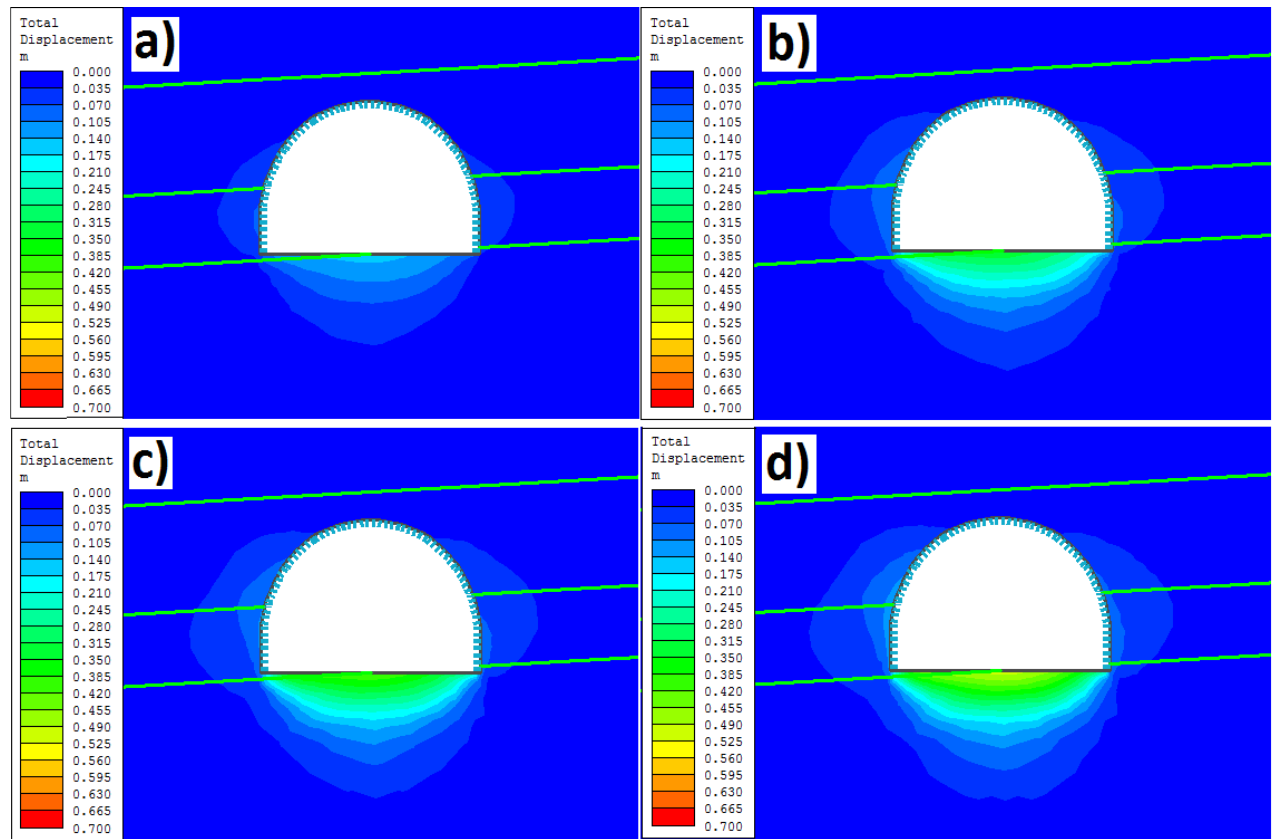
Figure 15. Charts of rock mass deformation around roadway F-33—chainage 405 m. ( a ) Deformation corresponding to measurements 36 days after roadway excavation. ( b ) Deformation corresponding to measurements 91 days after roadway excavation. ( c ) Deformation corresponding to measurements 153 days after roadway excavation. ( d ) Deformation corresponding to measurements 209 days after roadway excavation.